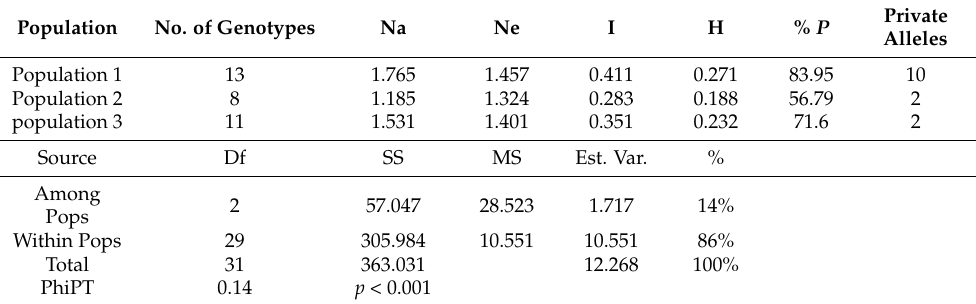
Table 6. Genetic diversity parameters, analysis of molecular variance (AMOVA), and population differentiation (PhiPT) result for quinoa populations obtained via SRAP alleles